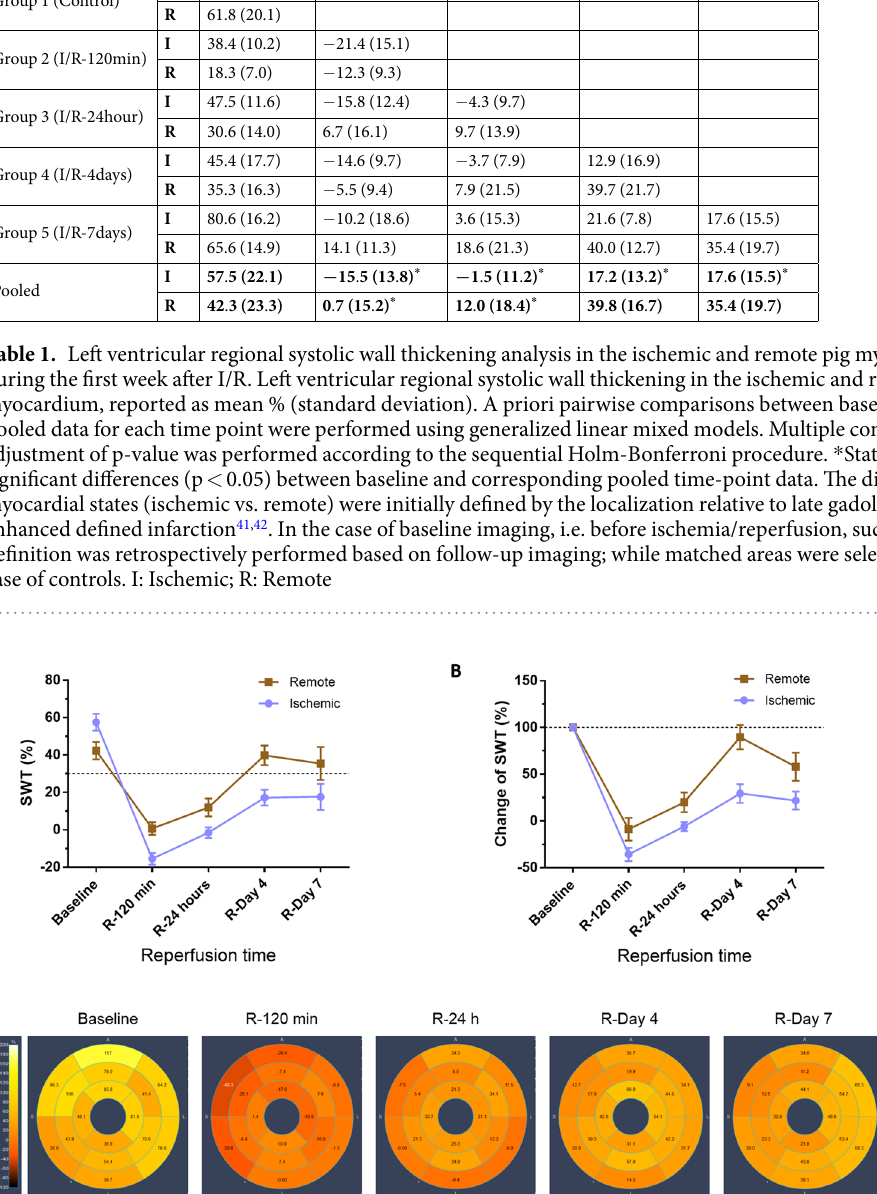
4 SCIENTIFIC REPoRTS | 7: 12343 | DOI:10.1038/s41598-017-11985-5